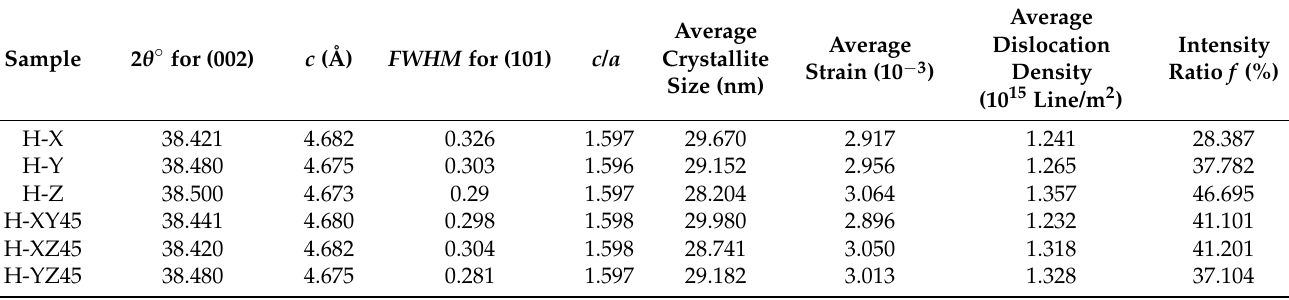
Table 7. The structural parameters of the α phase in aged